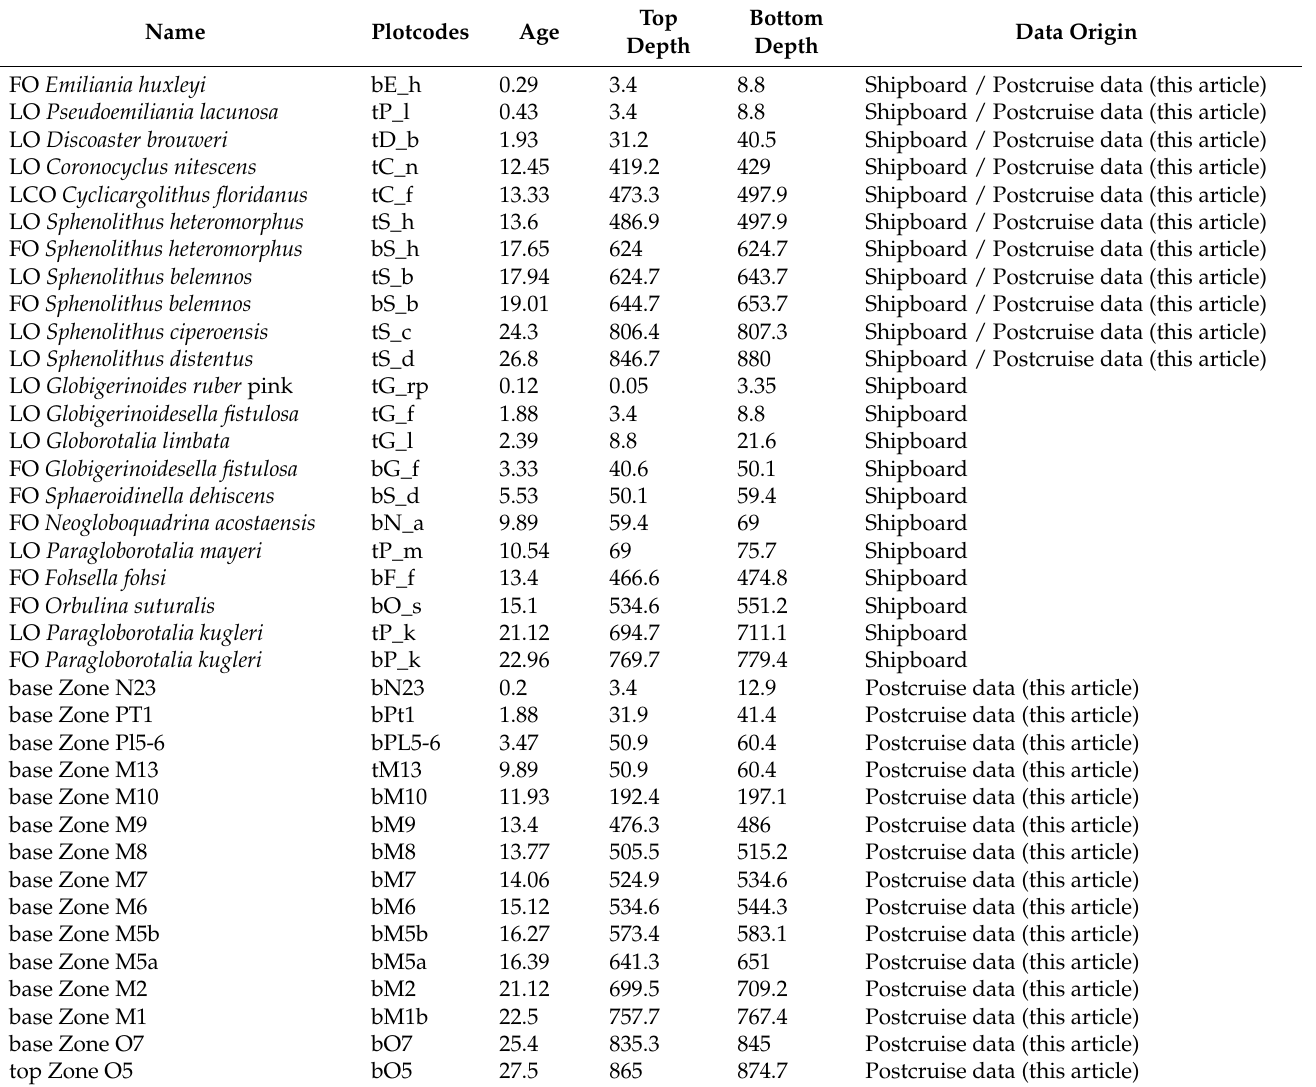
Table 1. List of bioevents identified in shipboard and shore-based studies of IODP Hole 359-U1468A together with ages used in this study [22,23]. Plot codes: bE_h = base Emiliania huxley ; tP_l =